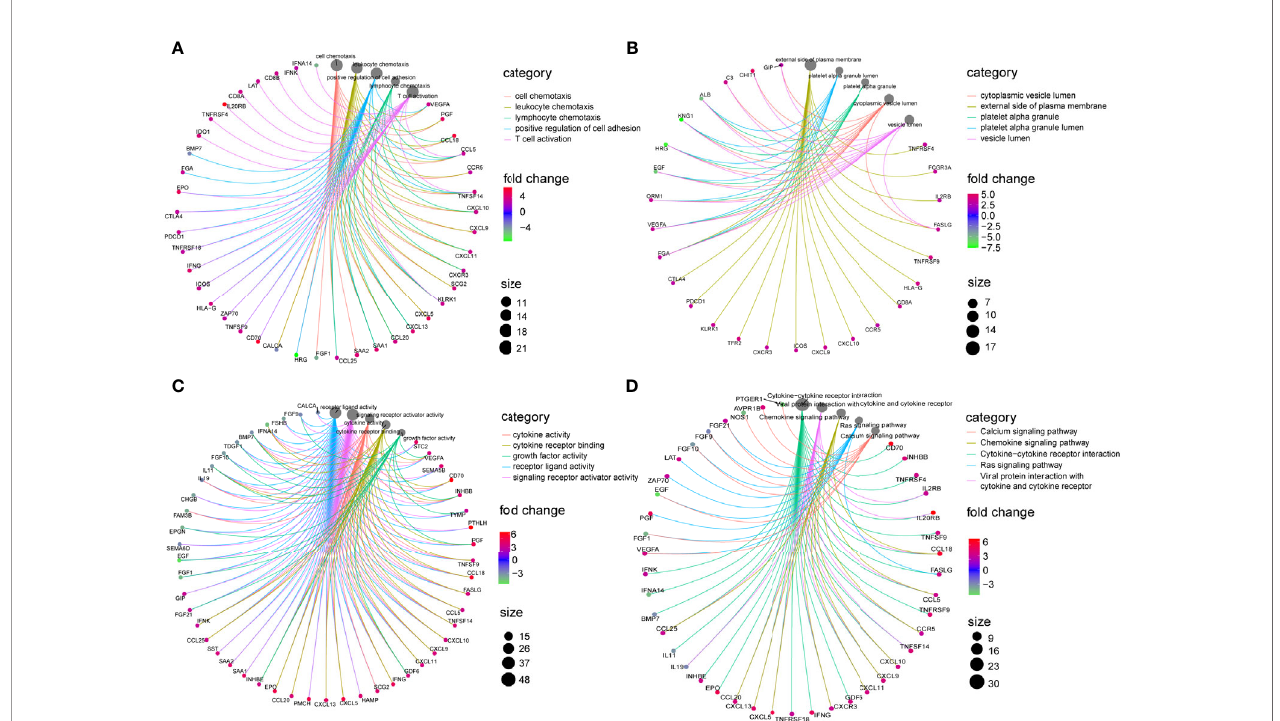
FIGURE 2 | Enrichment analysis of DE-IRGs. (A) Visualization of top 5 enriched GO analysis in BP. (B) Visualization of top 5 enriched GO analysis in CC. (C) Visualization of top 5 enriched GO analysis in MF. (D) Visualization of top 5 enriched KEGG